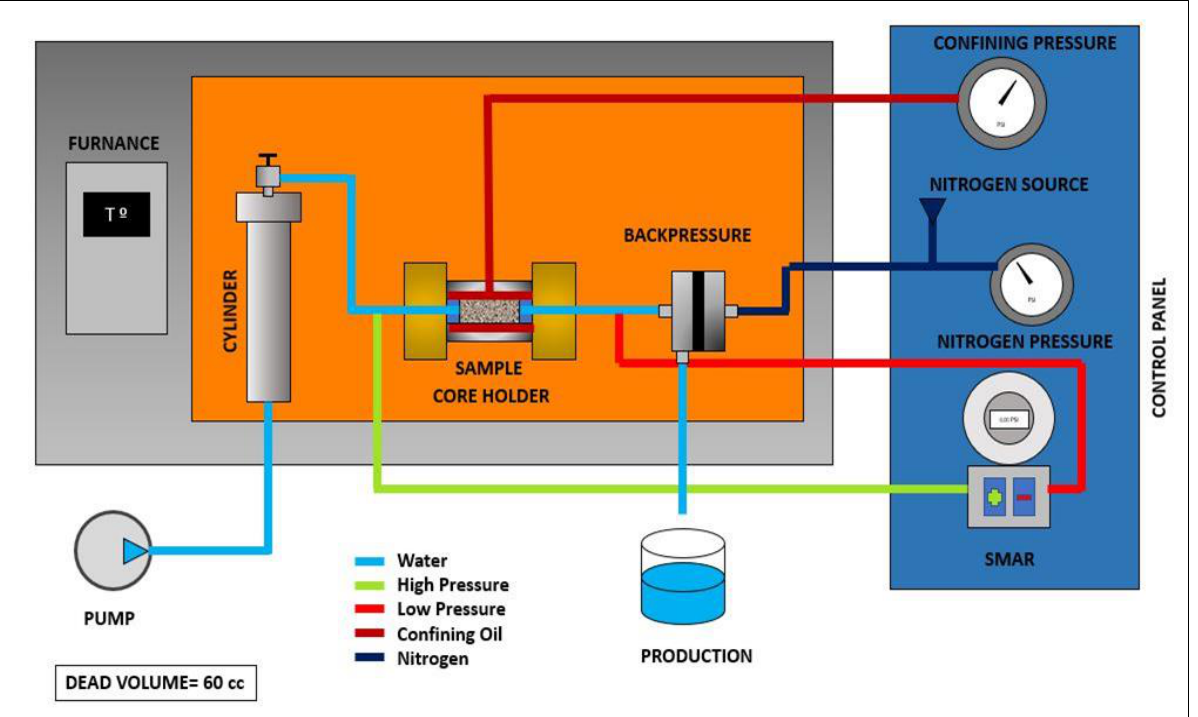
Figure 7: Schematic representation of the permeameter. Source: Authors,